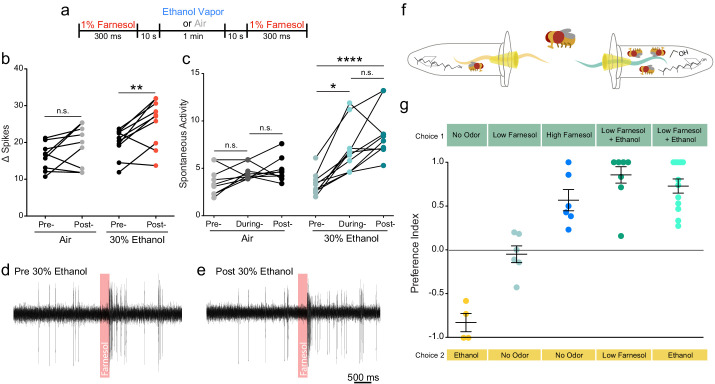
Ethanol increases attraction to and potentiates the neuronal response of a food related odor.(a) Paradigm used to evaluate farnesol responses pre- and post-ethanol treatment. Responses are shown in panels b-e. (b) Δ Spikes of farnesol-induced activity in ai2 sensilla, calculated as in 2b (paired two-tailed t-test, p=0.0059, n = 9–10). (c) Spontaneous activity before, during, and after ethanol exposure, calculated as in 2 c (Pre- vs. During Ethanol p=0.017, Pre- vs. Post-Ethanol p<0.0001, Kruskal-Wallis test with Dunn’s correction). (d, e) Traces from ai2 farnesol-sensing neurons. The red bar denotes a 300 ms farnesol exposure. (f) Graphic of the two-choice olfactory trap assay used to measure relative attraction to odors. (g) Preference Indices calculated as Number of flies in Choice 1-Number of flies in Choice 2/Total Number of flies. p>0.05, n.s. (not significant); p<0.05 *; p<0.01 **; p<0.0001 ****. Error bars denote SEM.